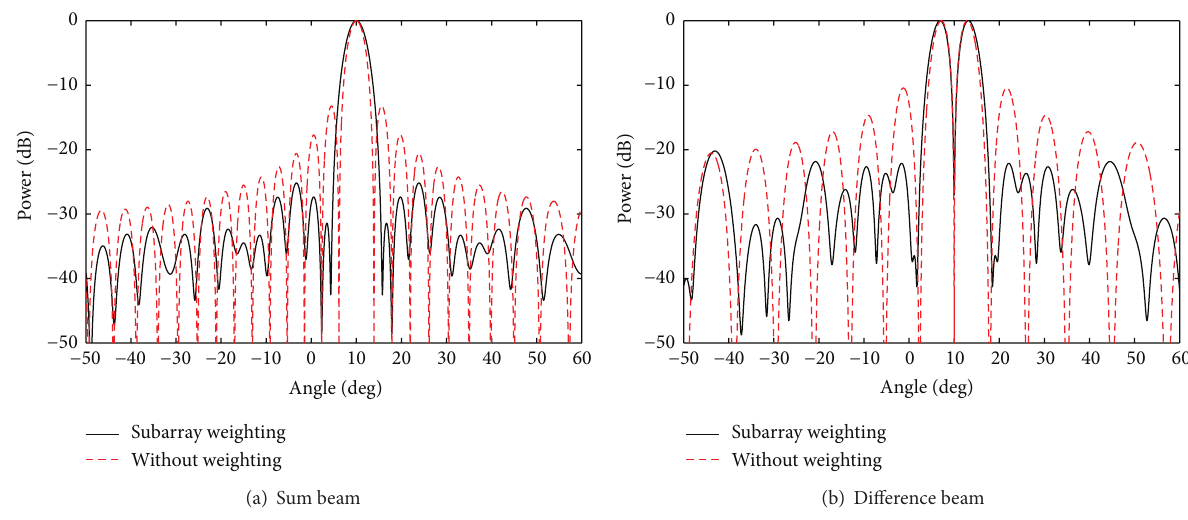
Figure 7: Subarrayed weighting-based quiescent